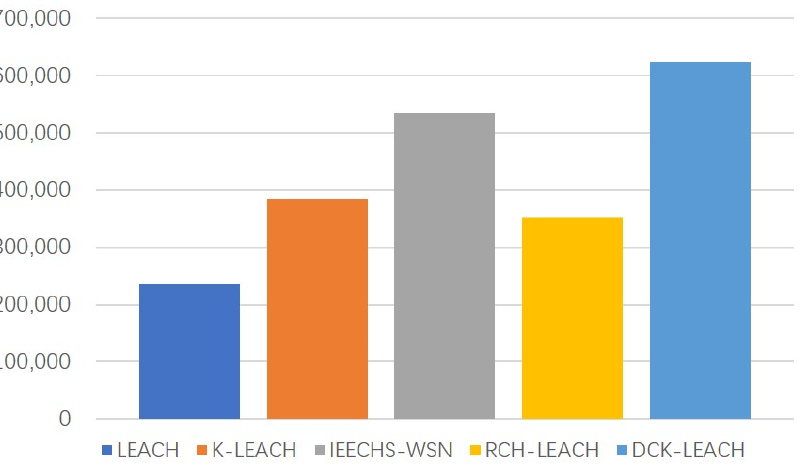
Figure 11. Number of packets (bits) received by the base station during the network is operational.